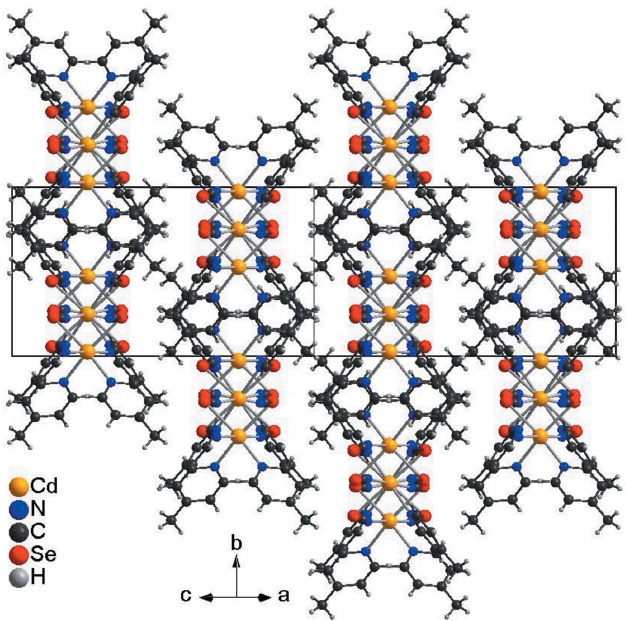
Figure 5 Crystal structure of compound 2 viewed along [101].